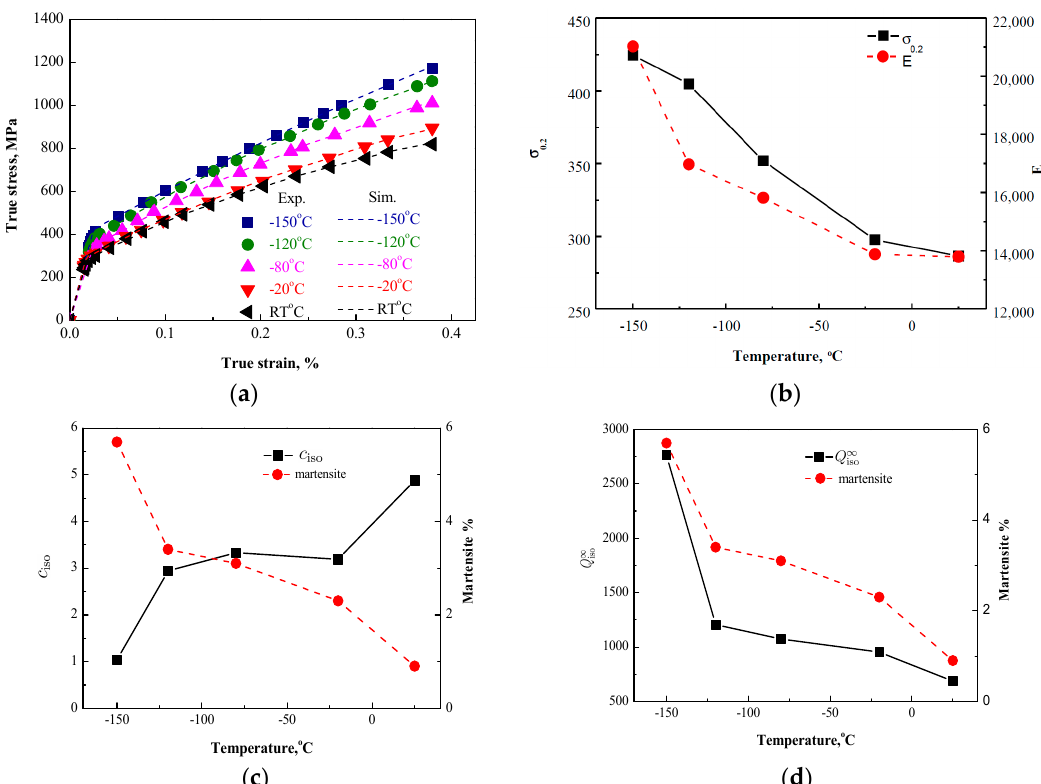
Figure 4. Comparison between experimental observations and numerical simulations ( a ); initial yield stress evolution and Young’s modulus versus temperature ( b ); model parameter C iso evolution and martensite content versus temperature ( c ); model parameter Q ∞ versus temperature ( d ).